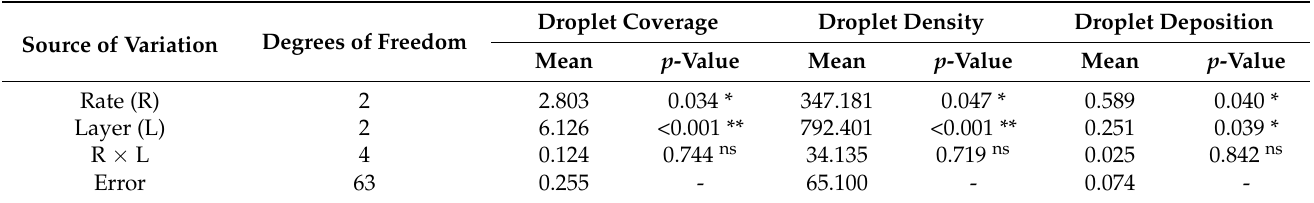
Table 5. Analysis of variance (ANOVA) for the effects of the application rates and canopy layers of coffee plants.